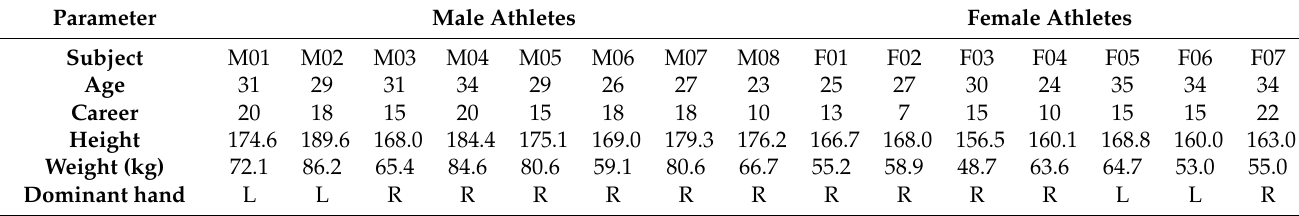
Table 1. Information of the